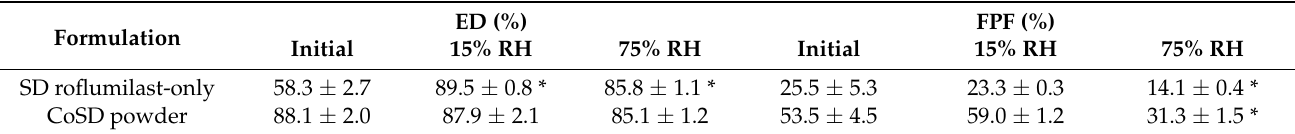
Figure 7. Scanning electron micrographs of spray ‐ dried roflumilast ‐ only powder after one ‐ month storage at 15% RH ( b ) and 75% RH ( c ) and cospray ‐ dried powder after one ‐ month storage at 15% RH ( e ) and 75% RH ( f ) (For ease of comparison, initial SEMs from Figure 4 for roflumilast ( a ) and cospray ‐ dried powder ( d ) are shown here). Table 6. In vitro aerosolization of spray-dried and cospray-dried roflumilast powders after one month of storage at 15% and 75% RH and 25 ◦ C. SD and CoSD mean spray-dried and cospray-dried, respectively; ED: emitted dose; FPF: fine particle fraction; data are means ± standard deviations, n = 3; initial data from Table 5 are used for comparison. * The value is significantly different ( p < 0.05) to the value on day 0